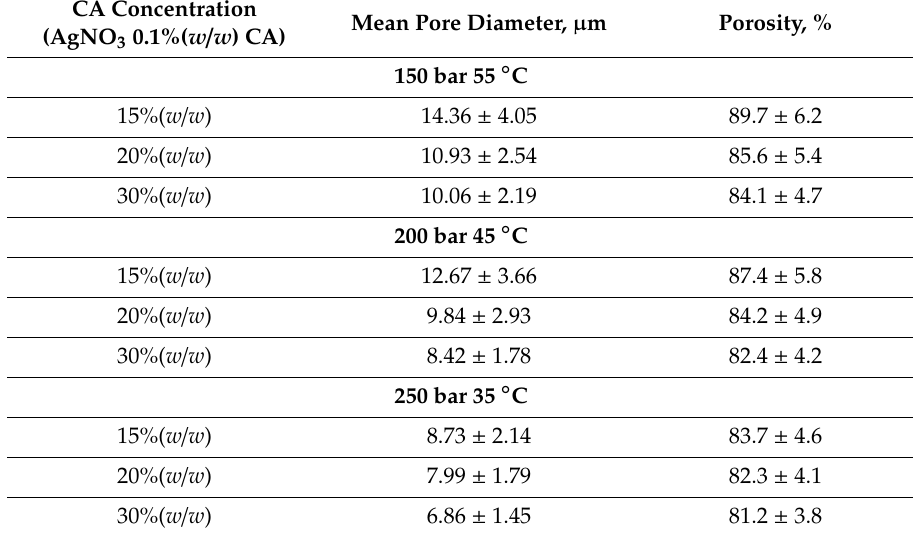
Table 1. Mean pore size and porosity of all the CA membranes loaded with AgNO 3 , produced in this